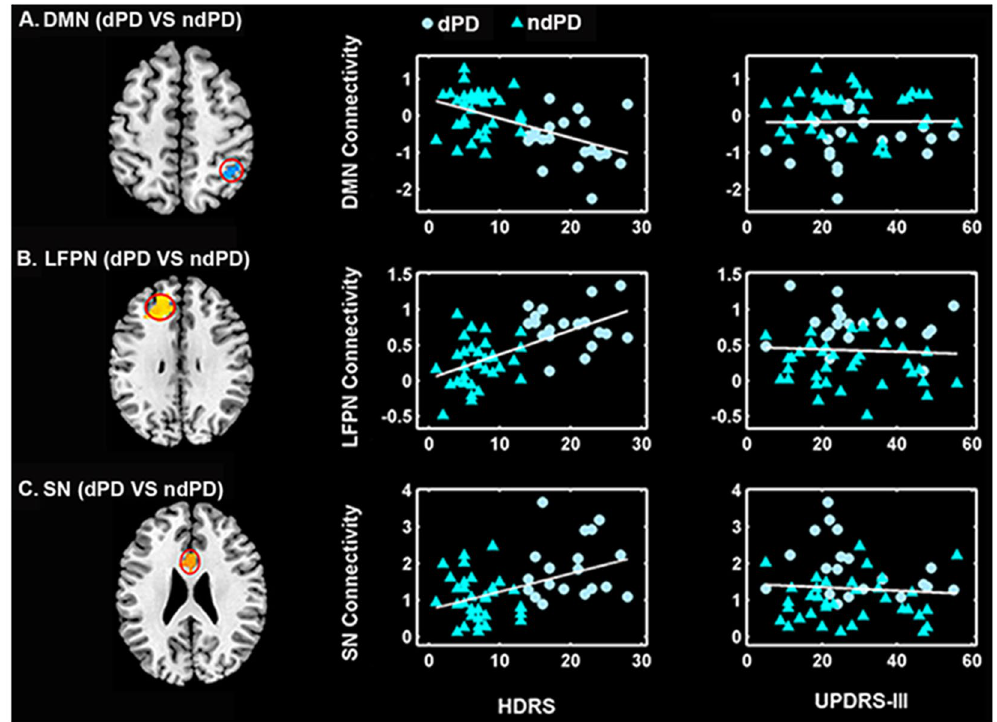
Figure 4. The correlations between intranetwork connectivity abnormities and the severity of depression and motor symptoms in PD. ( A ) DMN connectivity correlated negatively with HDRS scores (p < 0.001, r = − 0.48), and uncorrelated with UPDRS-III (p = 0.98, r = − 0.004) scores in PD. ( B ) LFPN connectivity correlated positively with HDRS scores (p < 0.001, r = 0.58), and uncorrelated with UPDRS-III (p = 0.96, r = 0.008) scores in PD. ( C ) SN connectivity correlated positively with HDRS scores (p = 0.004, r = 0.38), and uncorrelated with UPDRS-III (p = 0.89, r = − 0.02) scores in